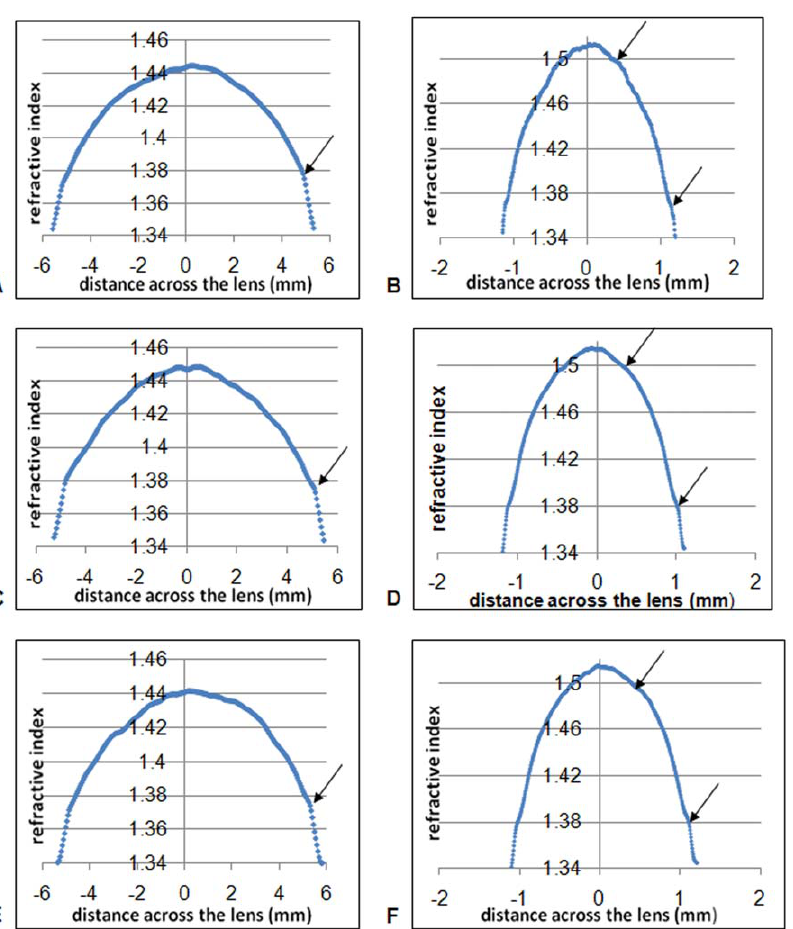
Figure 3. Refractive index profiles in the equatorial planes of three representative porcine (a),c) and e)) and three representative murine (b),d) and f)) lenses. Arrows point to discontinuities in the profiles.